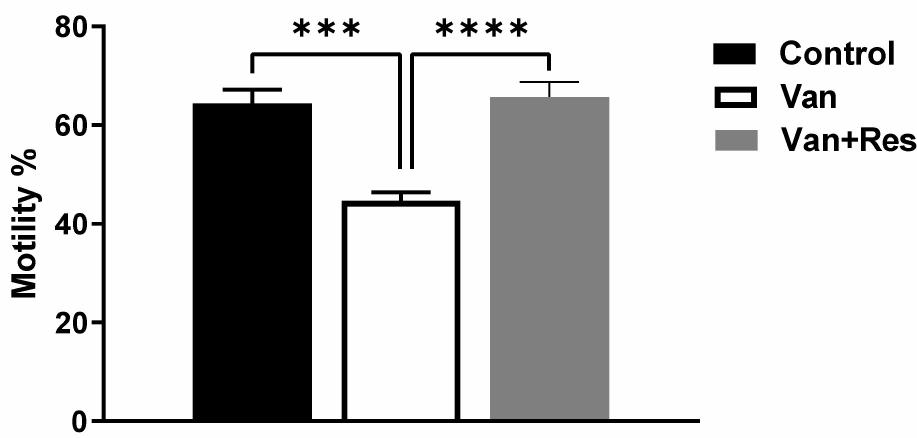
Figure 5. The effect of the resveratrol and vancomycin administration on the motility during the experiment. *** p < 0.001, **** p <